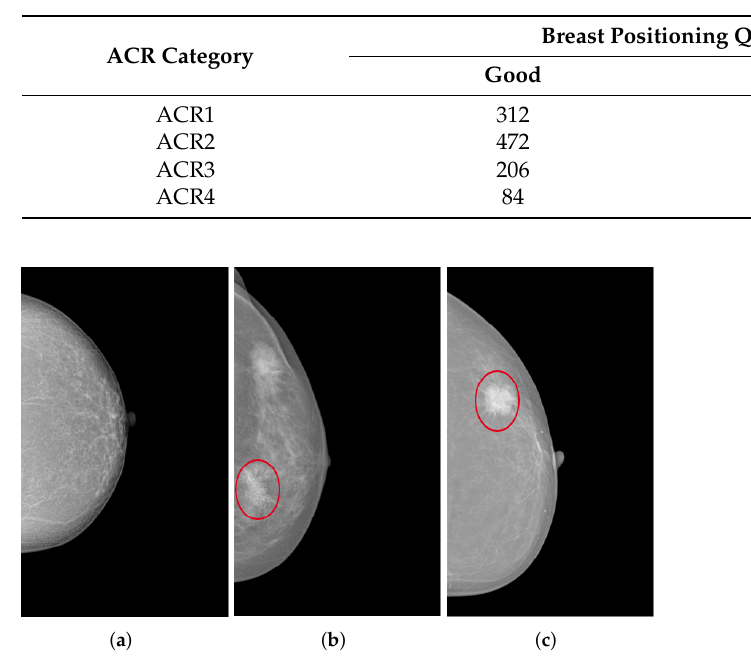
Table 2. Classification results of the collected 1556 CC views according to ACR categories and quality of breast positioning.